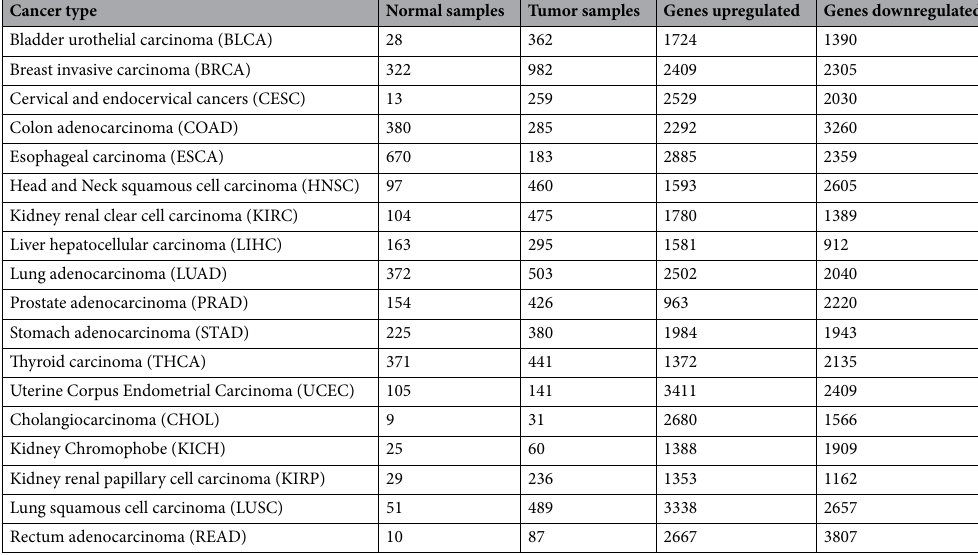
Table 1. List of cancer types included in the study along with the number of normal and tumor samples and their differentially regulated